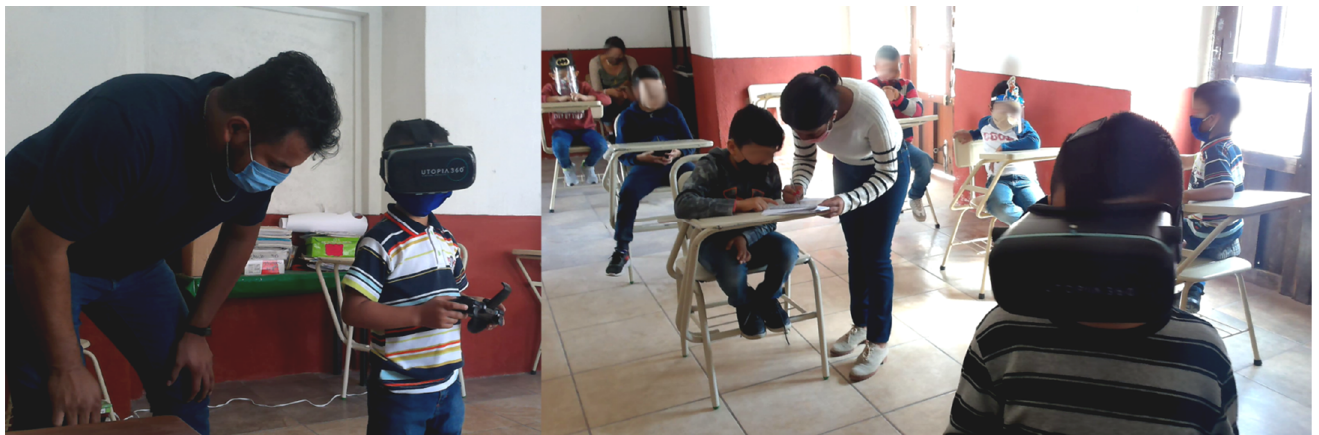
Figure A5. User task design related to the virtual environment Attention-VR.